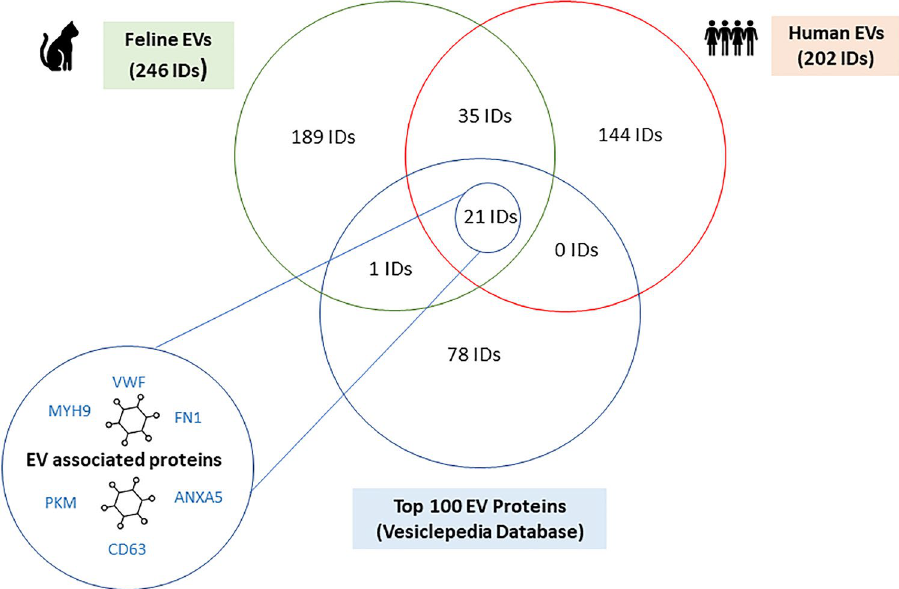
Figure 6. Venn Diagram showing the number of proteins identified by mass spectrometry (LC–MS/MS) in EVs isolated from human and feline plasma. Common proteins identified in both human and feline EVs included 21 proteins from the top 100 proteins present in extracellular vesicles (EVs) as identified by the Vesicplepedia database 21,22 . Additionally, 35 IDs were present in both human and feline EVs isolated by SEC. Some examples of EV associated proteins include VFW, CD63, ANXA5, FN1 and PKM (Supplementary Information).